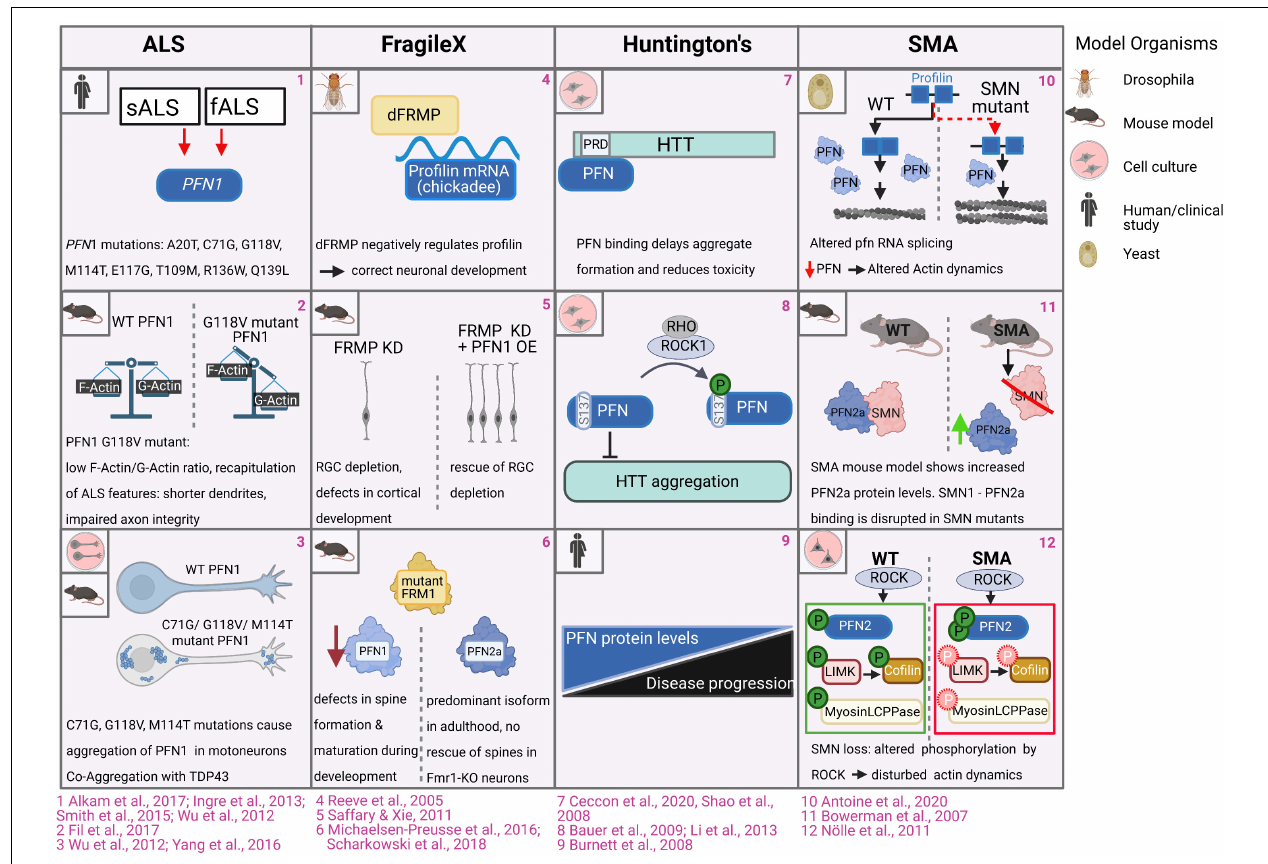
FIGURE 6 | Profilins in CNS pathologies. 1. Exome sequencing studies revealed 8 mutations in the Pfn1 gene in familial and sporadic ALS patients (Ingre et al., 2013; Wu et al., 2012; Chen et al., 2013; Smith et al., 2015; Alkam et al., 2017). 2. Motoneurons expressing ALS mutant PFN1 G188V exhibit abnormally low ratios of F-/G-actin. Motor neurons of ALS-PFN1-mutant expressing mouse model exhibited cytoskeletal disruptions and impaired axon integrity followed by Wallerian degeneration (Yang et al., 2016). 3. In cell culture and mice, wildtype PFN1 is diffusely distributed across the cytoplasm of motor neurons and N2A cells, while PFN1 C71G, PFN1 M114T and PFN1 G118V PFN mutations form protein aggregates and inclusions. PFN1 co-aggregates with TDP43 (Wu et al., 2012; Yang et al., 2016). 4 . FRMP directly binds the mRNA of Drosophila profilin (encoded by chickadee ), which is required for correct neuronal development in Drosophila (Reeve et